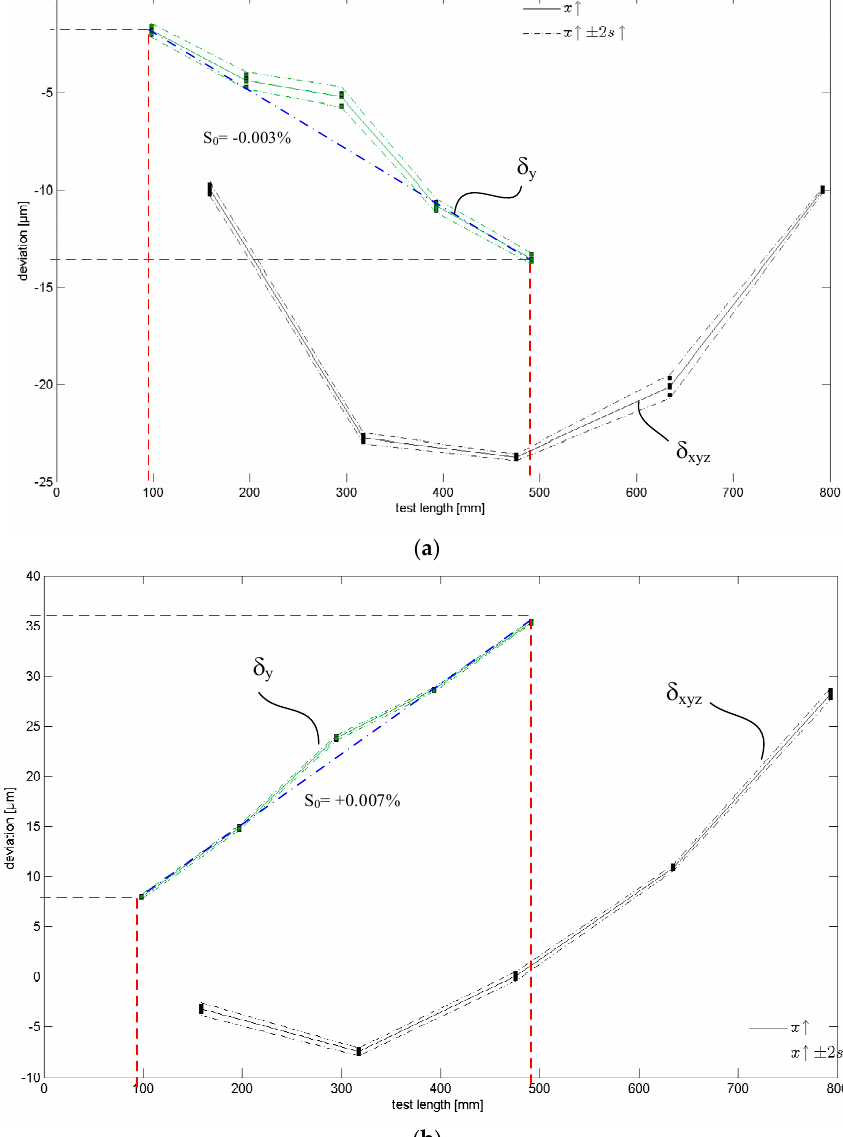
Figure 6 . Experiment results for x ‐ axis and xyz diagonal line test. ( a ) Original test result; ( b ) test result after proportional error given.